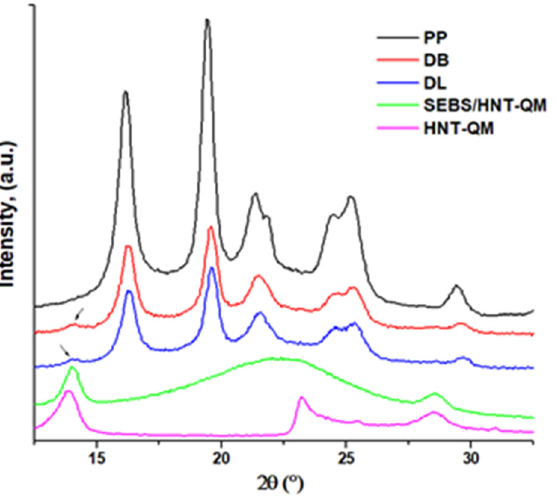
Figure 10. X-ray diffraction patterns of PP, HNT-QM, masterbatch and hybrid composites.